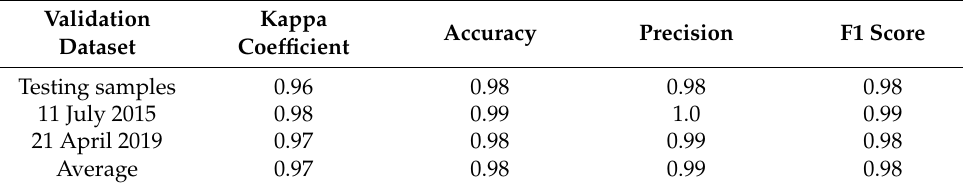
Table 2. Accuracy assessment for WaterUNet classification